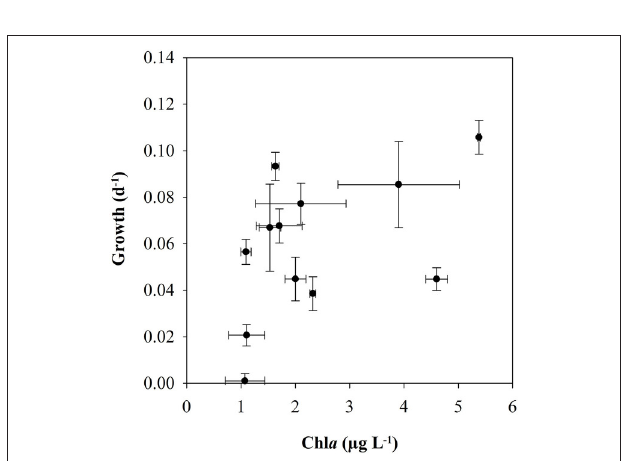
FIGURE 7 | Biovolume-specific growth rate (d − 1 ) of nauplii of C. finmarchicus vs. Chl a < 55 µ m (Pearson correlation coefficient 0.497, p =